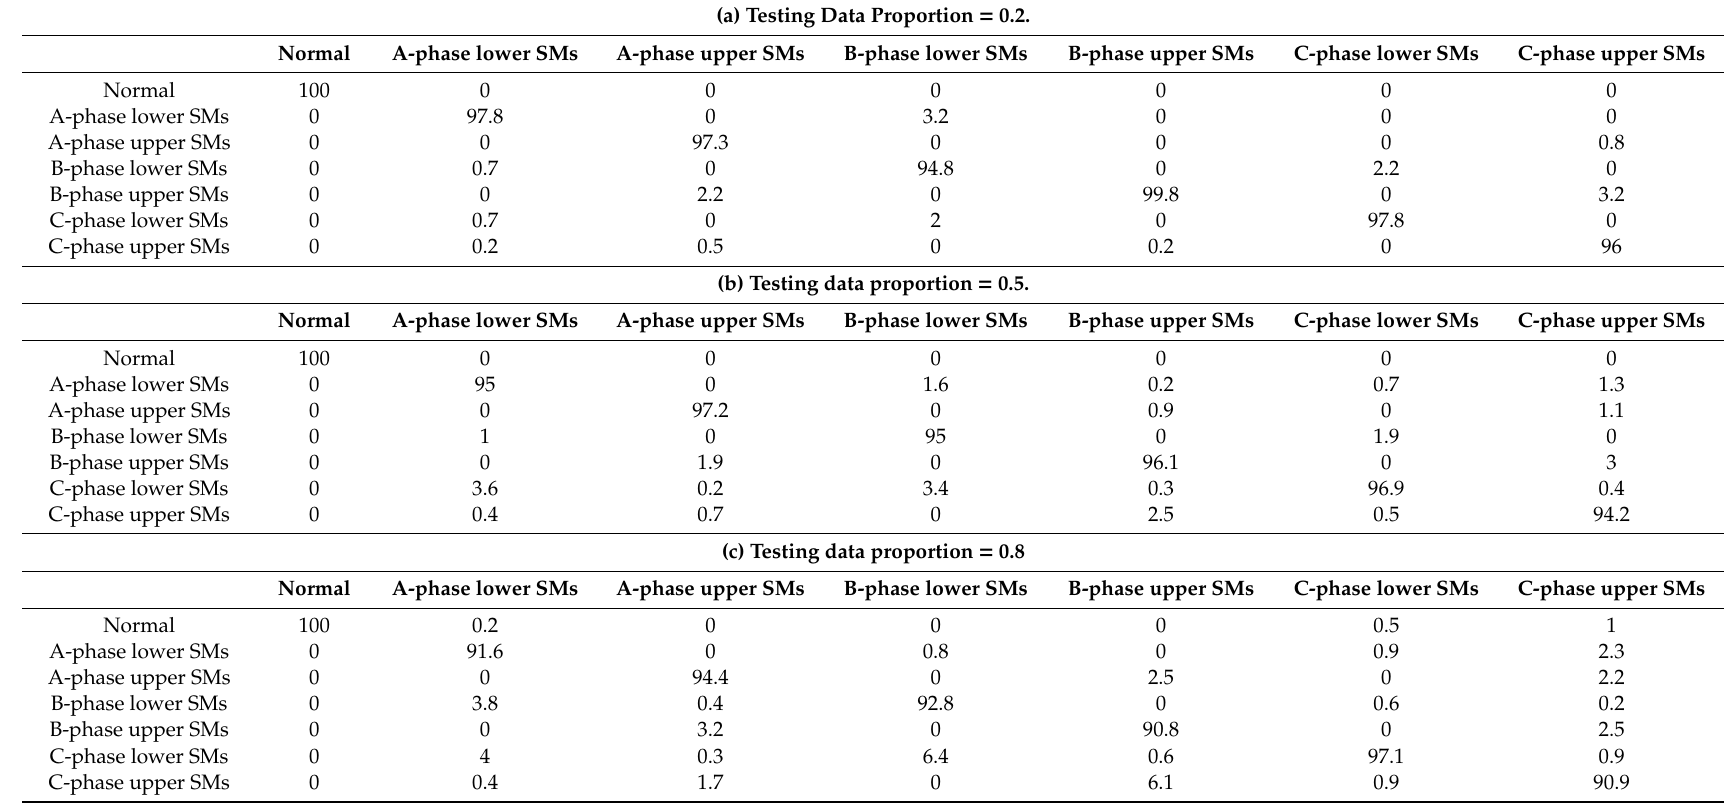
Table 4. Sample confusion matrix of the classification results of